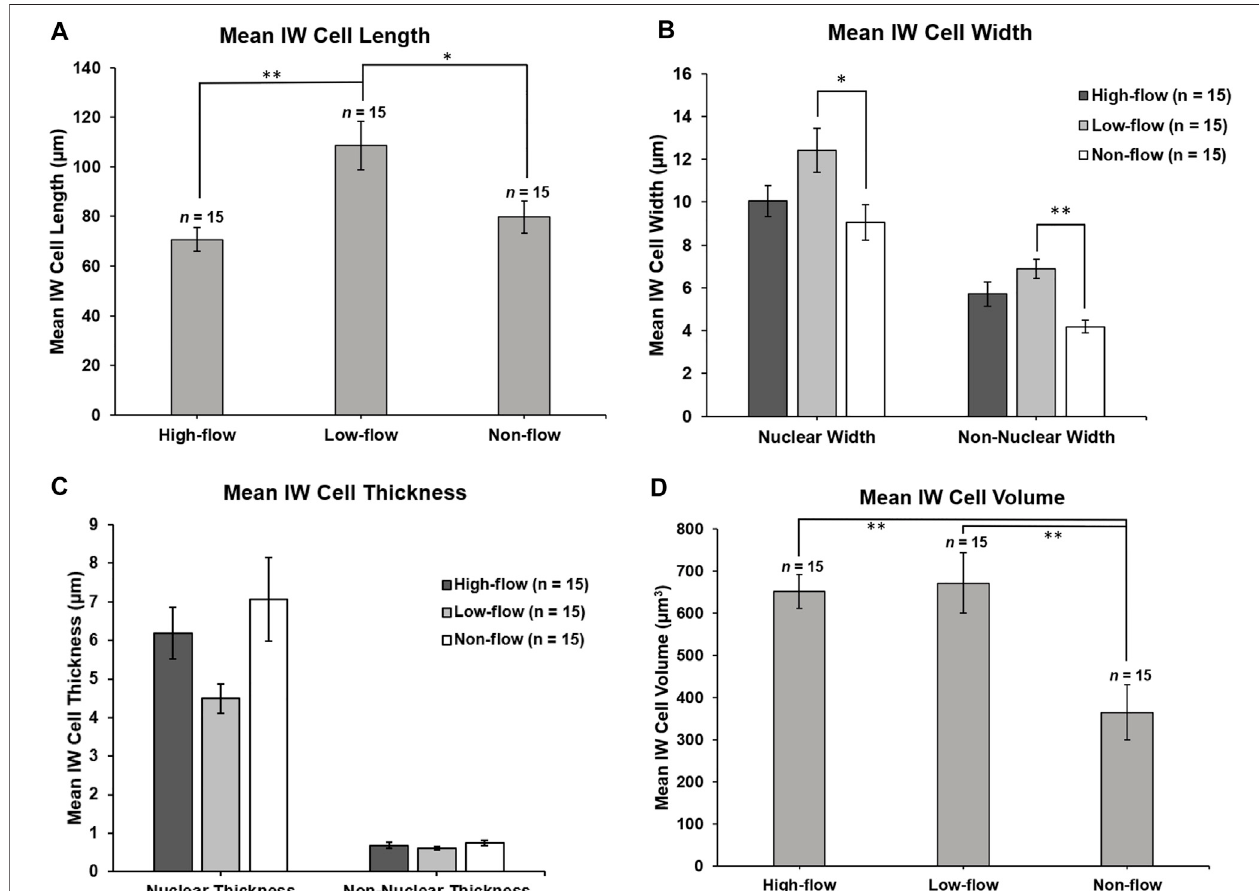
FIGURE 6 | Innerwallcelldimensions. (A) :MeanIWcelllengthwasmeasuredinthez-planethroughthestackofserialimages.IWcellsinlow- fl owareasweresigni fi cantly longer than IW cells in high- ( p = 0.02) and non- fl ow areas ( p ≤ 0.01). (B) : Mean nuclear IW cell width was measured on the section with the largest cross-sectional area of the nucleus. In nuclear regions, IW cells were signi fi cantly wider in low- fl ow areas than in non- fl ow areas ( p = 0.02). Non-nuclear IW cell width was measured on sections where the nucleuswasnotpresent.Innon-nuclearregions,IWcellsweresigni fi cantlywiderinlow- fl owareasthannon- fl owareas( p ≤ 0.01). (C) :MeanIWcellthickness(basal-to-apical height)innuclearregionswasnotsigni fi cantlydifferentamongcellsindifferent fl ow-typeareas( p =0.06).MeanIWcellthicknessinnon-nuclearregionswasnotsigni fi cantlydifferent amongcellsindifferent fl ow-typeareas( p =0.24). (D) :MeanIWcellvolumewascalculatedbysubtractingthevolumeofgiantvacuolesfromthecelltraces.MeanvolumesofIW cells in high- and low- fl ow areas were signi fi cantly larger than IW cells in non- fl ow areas (both p ≤ 0.01). * p < 0.05; ** p ≤ 0.01. Error bars : SEM.